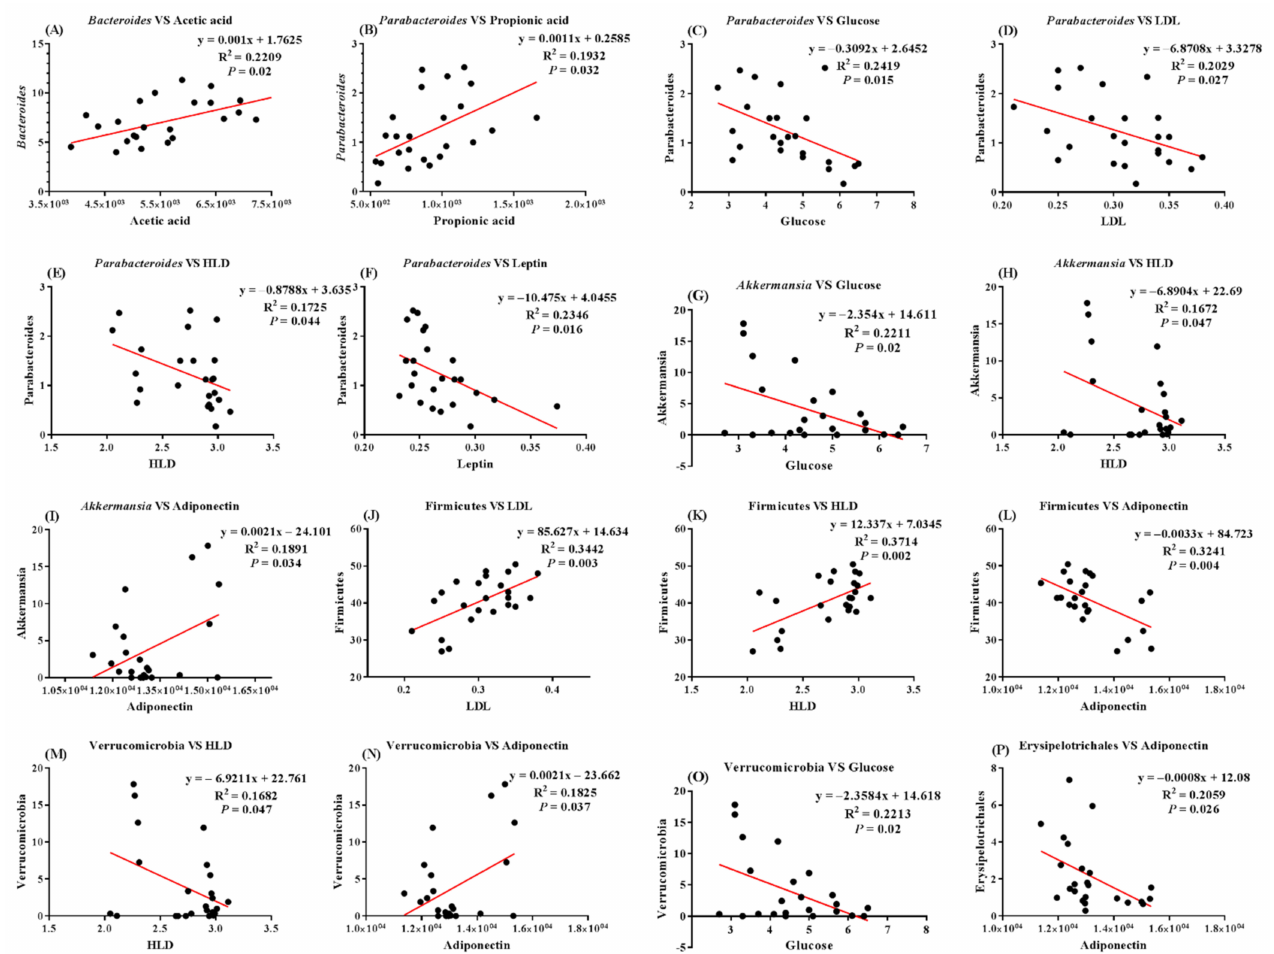
Figure 8. Correlation analysis between the gut microbe with SCFAs (short-chain fatty acids) and the lipid deposition-related factor. ( A ) Bacteroides vs. acetic acid; ( B ) Parabacteroides vs. propionic acid; ( C ) Parabacteroides vs. GLU; ( D ) Parabacteroides vs. LDL; ( E ) Parabacteroides vs. HLD; ( F ) Parabacteroides vs. leptin; ( G ) Akkermansia vs. GLU; ( H ) Akkermansia vs. HLD; ( I ) Akkermansia vs. adiponectin; ( J ) Firmicutes vs. LDL; ( K ) Firmicutes vs. HLD; ( L ) Firmicutes vs. adiponectin; ( M ) Verrucomicrobia vs. HLD; ( N ) Verrucomicrobia vs. adiponectin; ( O ) Verrucomicrobia vs. GLU; ( P ) Erysipelotrichales vs.